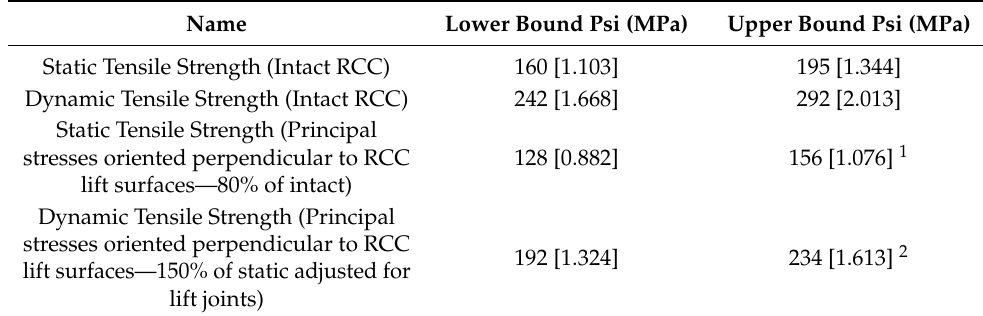
Table 5. Summary of estimated tensile strength of RCC materials for structural analyses and evalua- tion of modeling